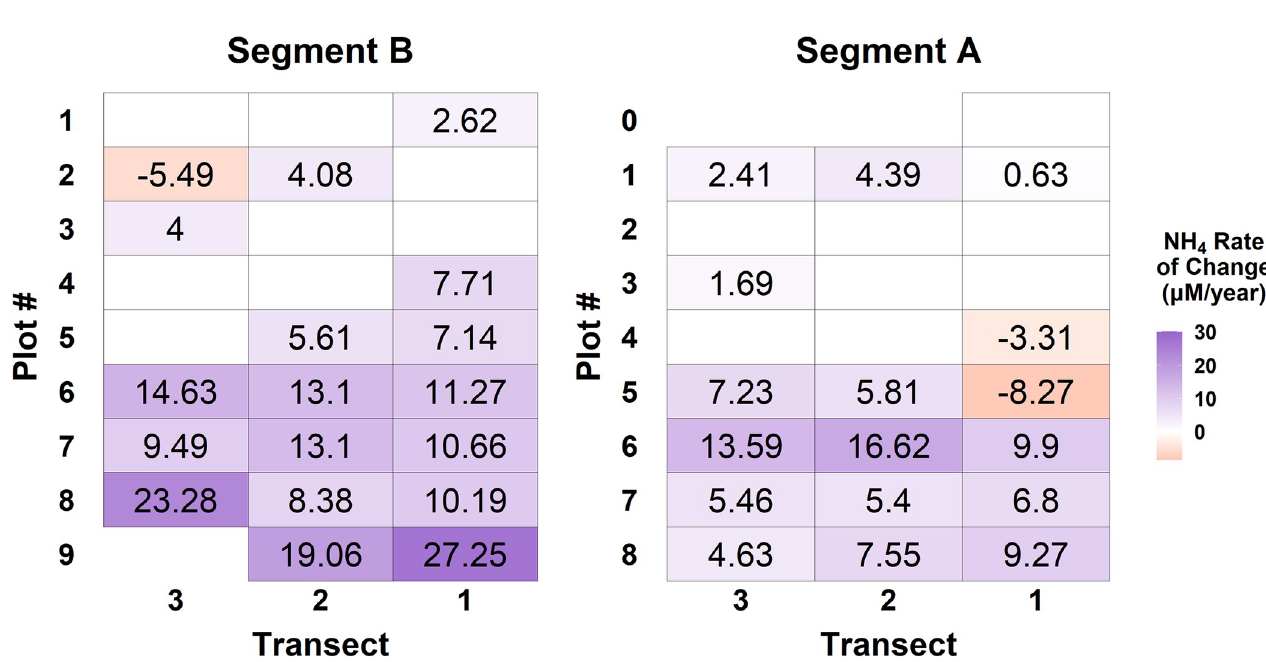
Fig 6. NH 4 rates of change. Rates of change in NH 4 ( μ mol L -1 ) corresponding to each permanent vegetation monitoring plot across Segments A and B. The numbers in each plot represent the slope of the linear fit between average monthly porewater NH 4 concentration (from May-August) and years from 2009– 2019 where p < 0.05. Plot shading visualizes the spatial variability in rates of change, and plots with no number/shading had non-significant temporal trends. Segment B is upstream and west of Segment A, so they are plotted here as they are oriented in the field.